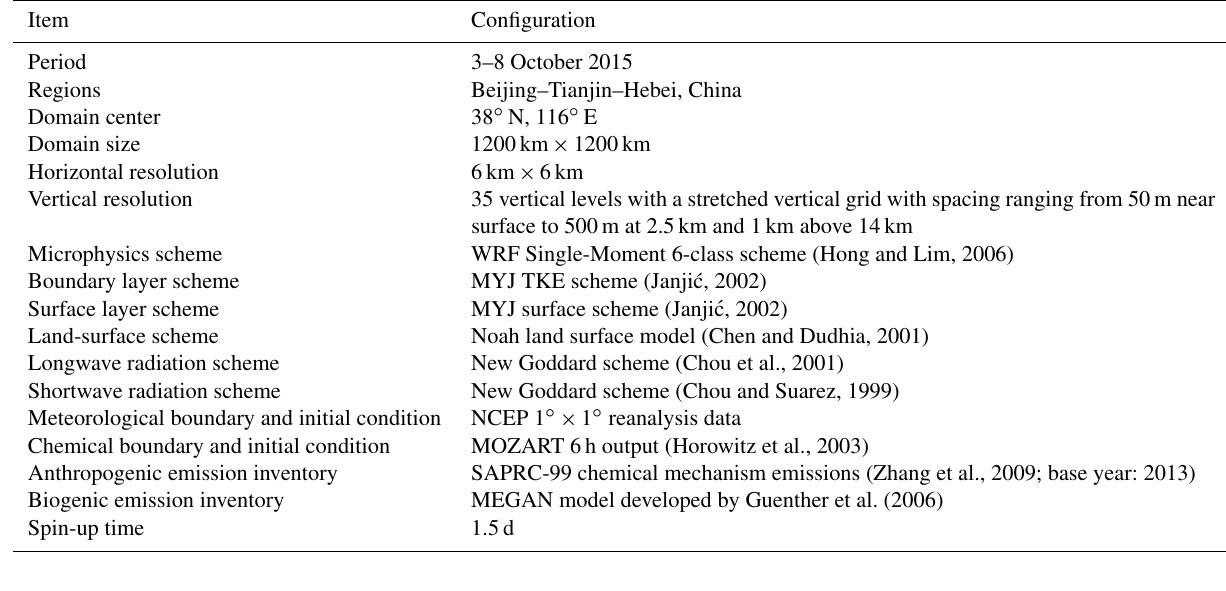
Table 2. WRF-Chem model configuration.